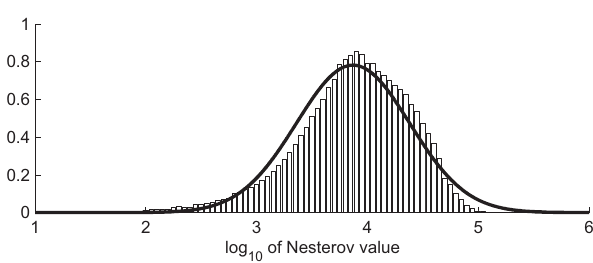
Fig. 7. Sum of burned area fractions versus log 10 of the Nesterov indices, rescaled to a maximum area of 1. This curve was gener- ated using the same training data as used in the remaining analysis (e.g. all locations outside the area from 20 ◦ E to 30 ◦ E indicated in Fig. 1).